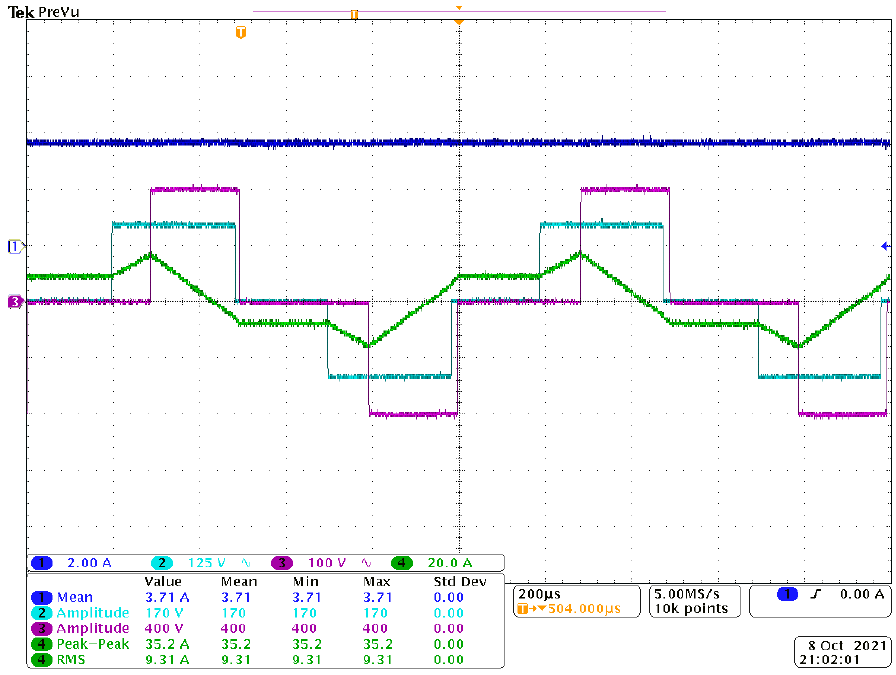
Figure 25. DAB operation at medium power under the TPS-based